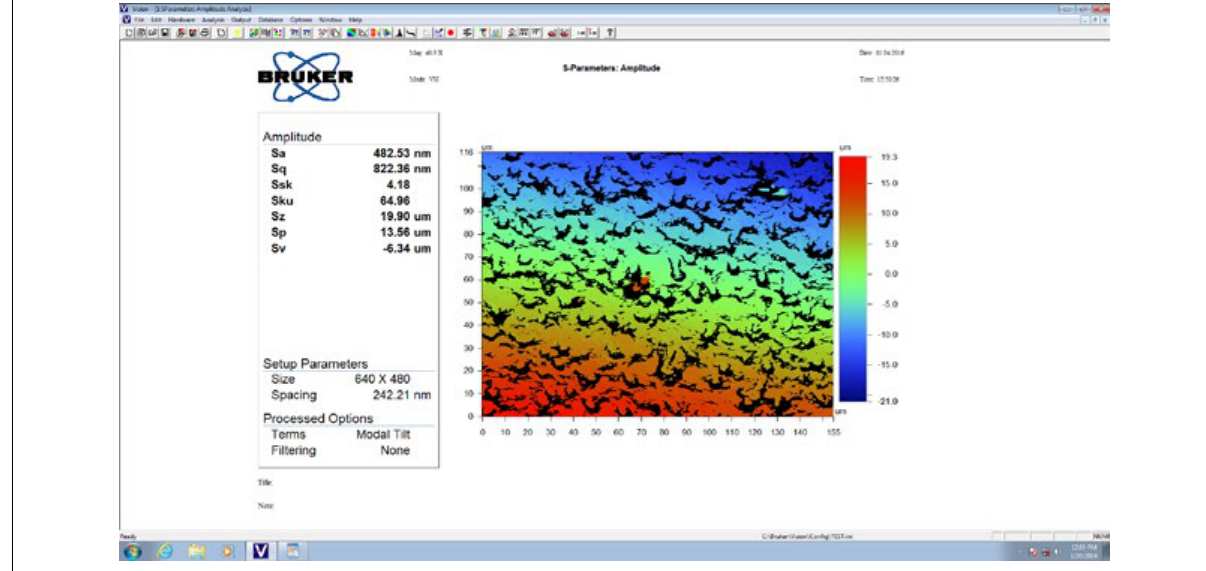
Figure 3. Surface roughness measurement using